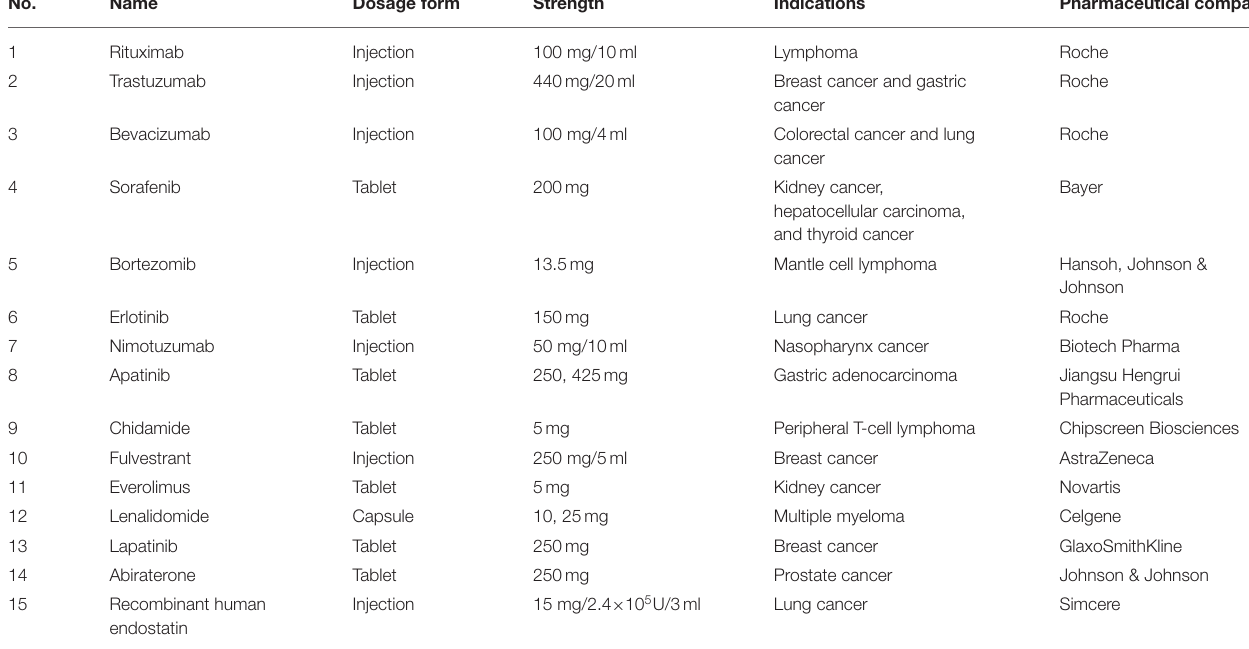
TABLE 1 | Baseline information of 15 innovative anti-cancer medicines.